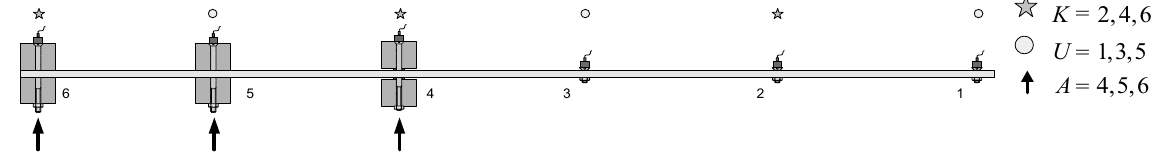
Fig. 5. Co-ordinates associated to known and unknown responses and to the applied loads.